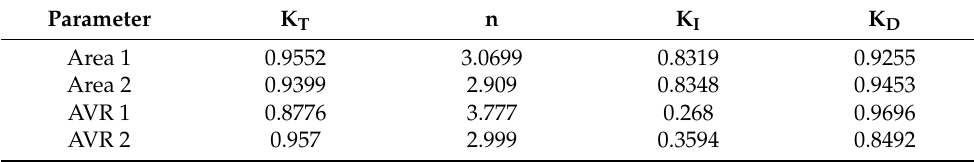
Table 16. TID parameters for the combined AGC and AVR